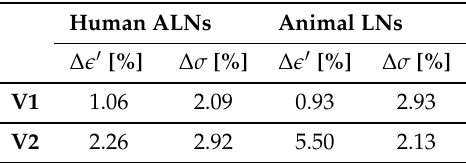
Dielectric measurement validation result: mean percentage difference, considering all measurement sessions, between the permittivity inferred from the validation measurements and the reference values. Data are separated between pre-measurement validation (V1) and post-measurement validation (V2). Moreover, the left side of the table refers to human axillary lymph node (ALN) measurements, while the right side of the table refers to animal lymph node (LN)